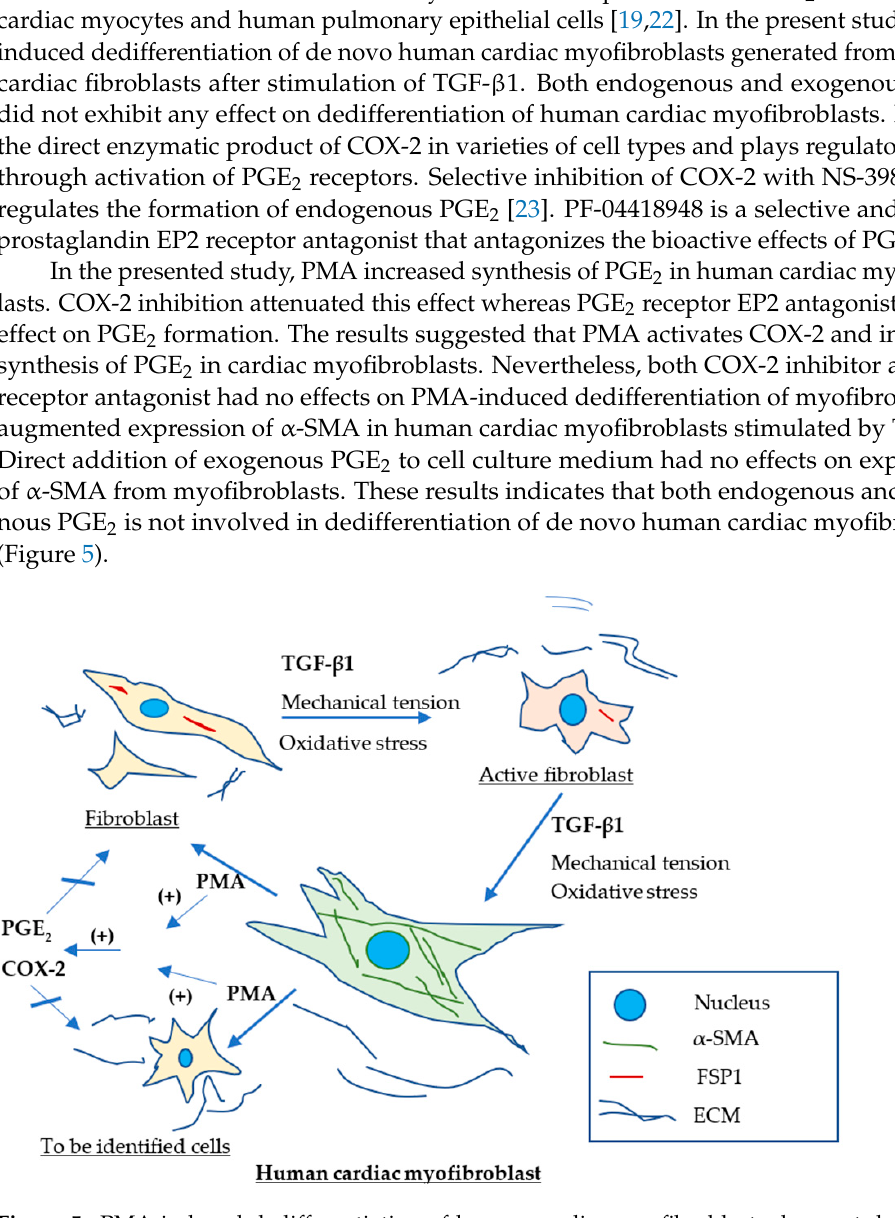
Figure 5. PMA-induced dedifferentiation of human cardiac myofibroblasts does not depend on activation of COX-2/PGE 2 pathway. A schematic outlines dedifferentiation of cardiac myofibroblasts induced by PMA and the role of COX2/PGE 2 activation in dedifferentiation of myofibroblasts. TGF- β 1 and/or other factors, such as increased mechanical tension, inflammation, or oxidative stress promote differentiation of human cardiac fibroblasts to myofibroblasts though active fibroblasts. PMA dedifferentiates cardiac myofibroblasts to fibroblasts and/or other unidentified cell type. PMA increases activity of COX-2 and formation of PGE 2 . Deactivation of COX-2 and PGE 2 produces no effects on PMA-induced dedifferentiation of cardiac myofibroblasts. (+) denotes